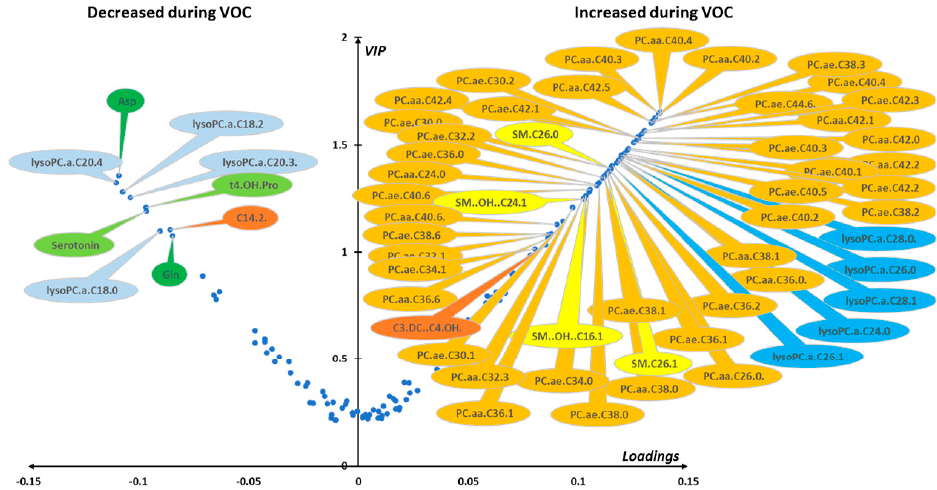
Figure 5. (red blood cells). Loading vs. VIP (volcano plot) for PLS-DA models constructed from red cell samples. Median loading and VIP values were calculated for each metabolite using 7955 best models (BMs) (i.e., AUROCva ≥ 0.95). Only the most important metabolites, that is, those with VIP ≥ 1,